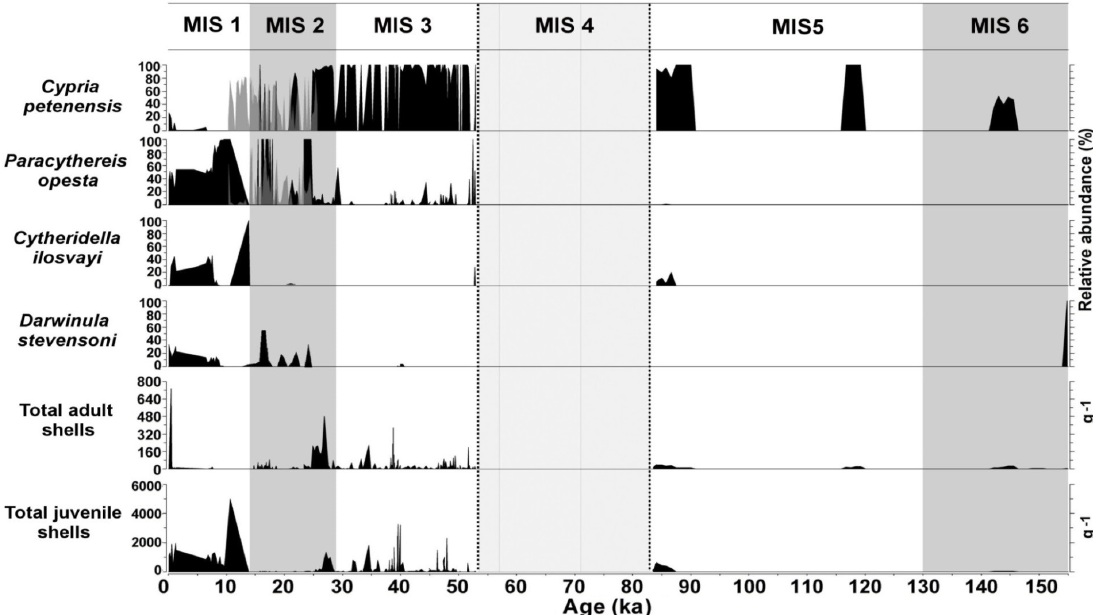
Figure 6. Master profile of the fossil ostracode record during marine isotope stages of the last 155kyr in Lake Petén Itzá. Zone delimited by dashed lines represents a period of data absence. Grey peaks during the period of 24–10 represent results from core PI-6, whereas black peaks during the same period represent results from core